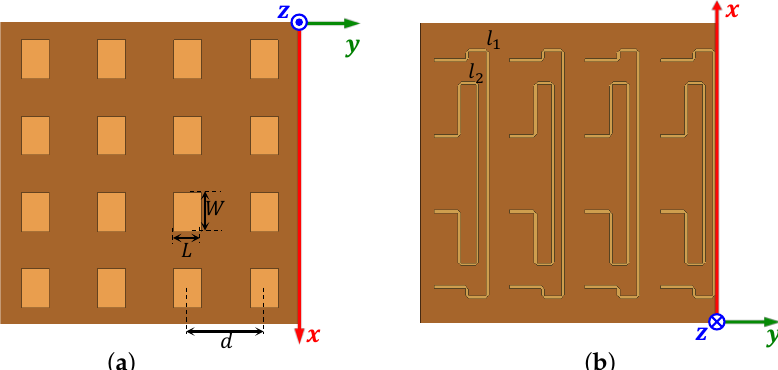
Figure 16. The geometry of the four by four finite array of rectangular microstrip patch antennas that are connected in the van Atta configuration in the xz -plane, ( a ) top. ( b )